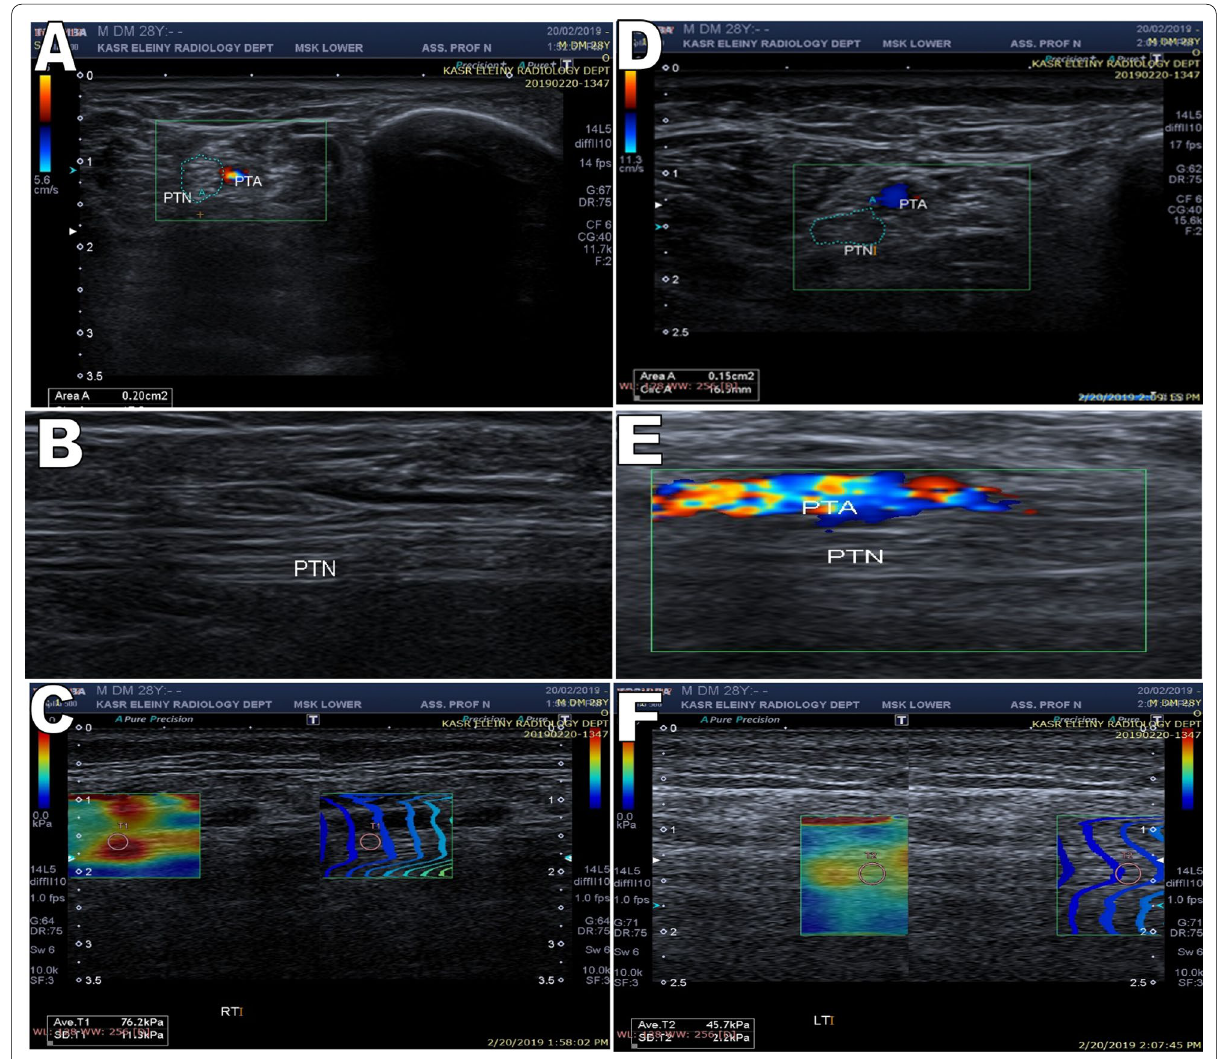
Fig. 2 A 63-year-old male patient diabetic for 28 years on insulin treatment with uncontrolled blood sugar and elevated Hb A1c, presented with bilateral lower limb numbness, tingling, and burning sensation as well as axonal neuropathy on nerve conduction study. High-resolution ultrasound A shows the right PTN in relation to the PTA with its CSA measuring 20 mm 2 . B B-mode image shows the longitudinal axis of the right PTN. C The right image is the B-mode, and the left image measures the elasticity of the PTN (76.2 kPa) with a color-coded box, circular ROI (T1) for quantitative measurements and a color code scale at the top side of the image. D demonstrates the left PTN in relation to the PTA with its CSA measuring 15 mm 2 . E B-mode image shows the longitudinal axis of the left PTN. F The elasticity of the PTN (45.7 kPa) with a color-coded box, circular ROI (T2) for quantitative measurements, and a color code scale at the top side of the image. There is an increase in the CSA and stiffness of both posterior tibial